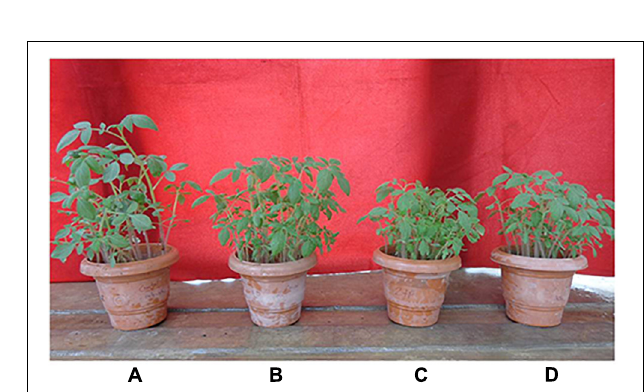
FIGURE 1 | Phylogenetic tree constructed by using neighbor-joining analysis between BHU-AV3 isolate and reference bacterial sequences retrieved from GenBank based on 16S rDNA sequences. The tree shows the phylogenetic position of BHU-AV3 isolate among the genus of Sphingobacterium . GenBank accession numbers are given in parentheses. Numbers at nodes indicate percentages of bootstrap support, based on 1,000 resample datasets. Evolutionary analyses were conducted in MEGA7.